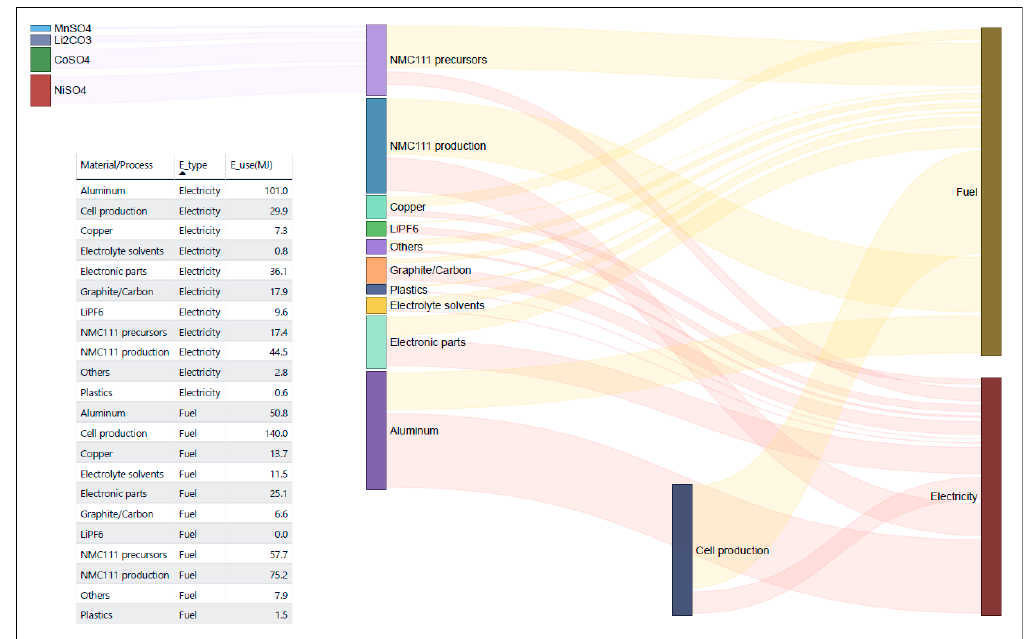
Figure 4. Process energy use for the production of 1 kWh NMC111 battery and its material constituents, assuming all materials are virgin.